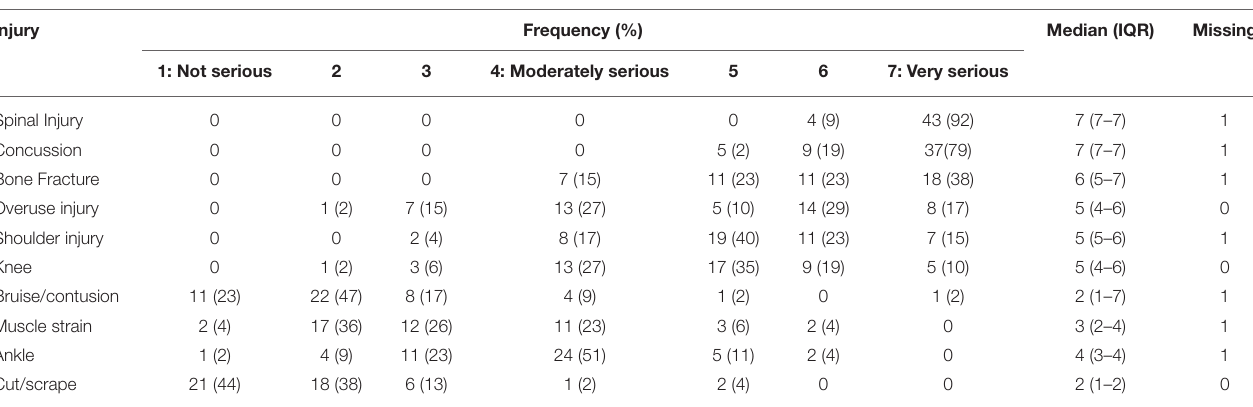
TABLE 2 | Coach injury severity perceptions on pre-workshop questionnaire. Injury Frequency (%) Median (IQR)